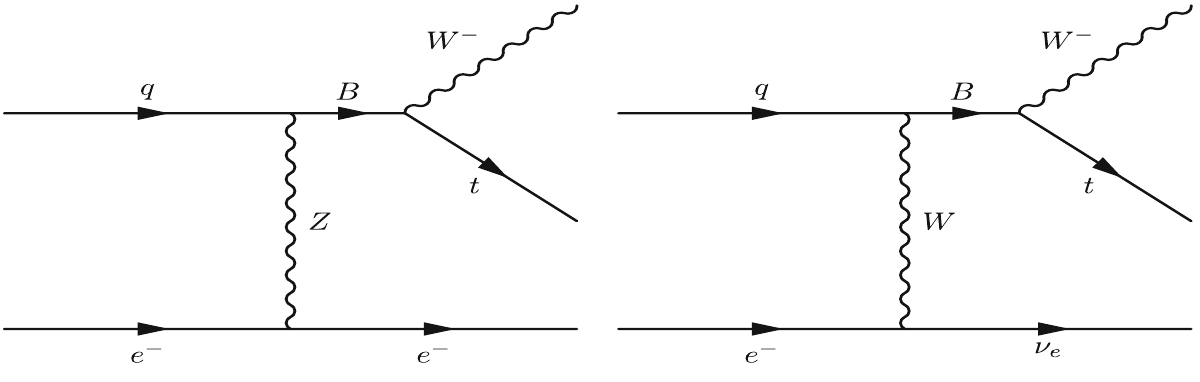
Fig. 2 The Feynman diagrams for single production of VLQ- B at the LHeC including the decay channel B → Wt